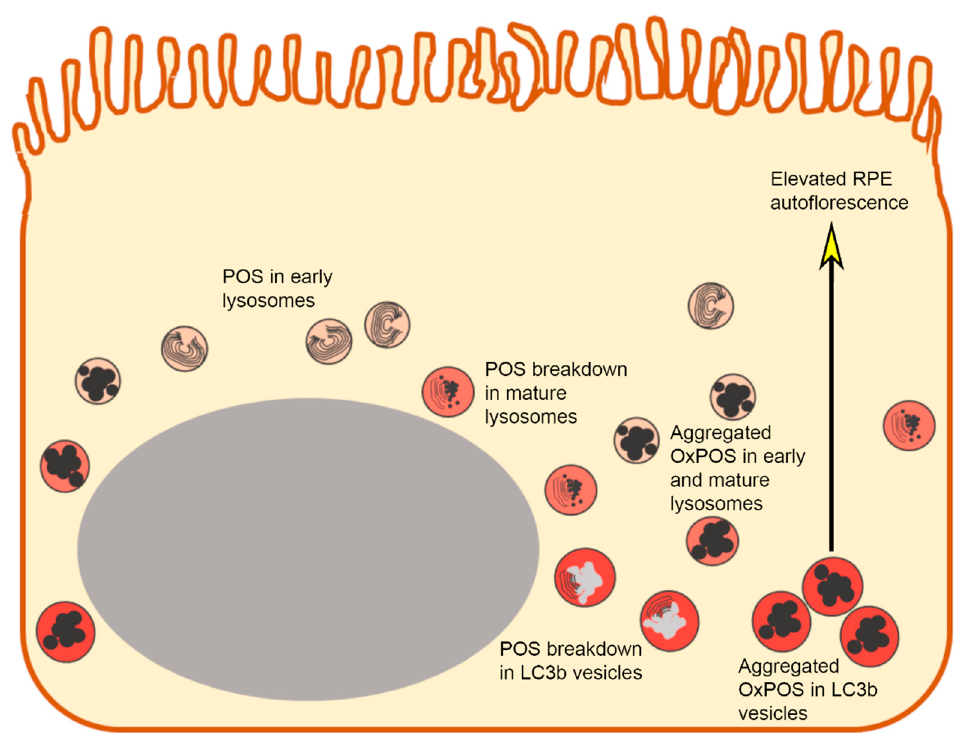
Figure 8. Summary diagram showing an in vitro RPE cell model recapitulating pathogenic features following exposure to OxPOS. (a) The accumulation of intracellular macromolecules, (b) oxidative stress and (c) damaged intracellular cargo trafficking and autophagy.